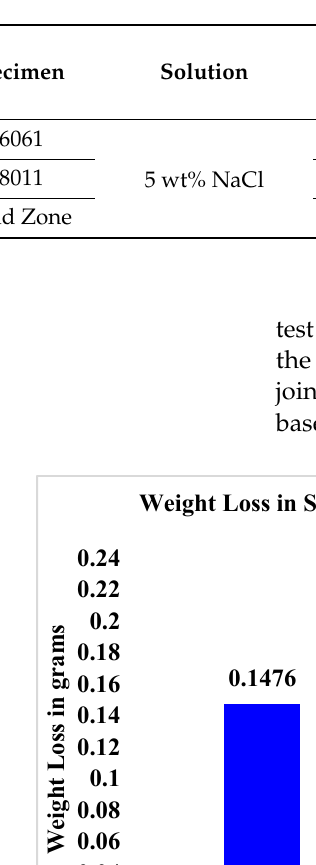
Table 5. Summary of the salt spraying test.